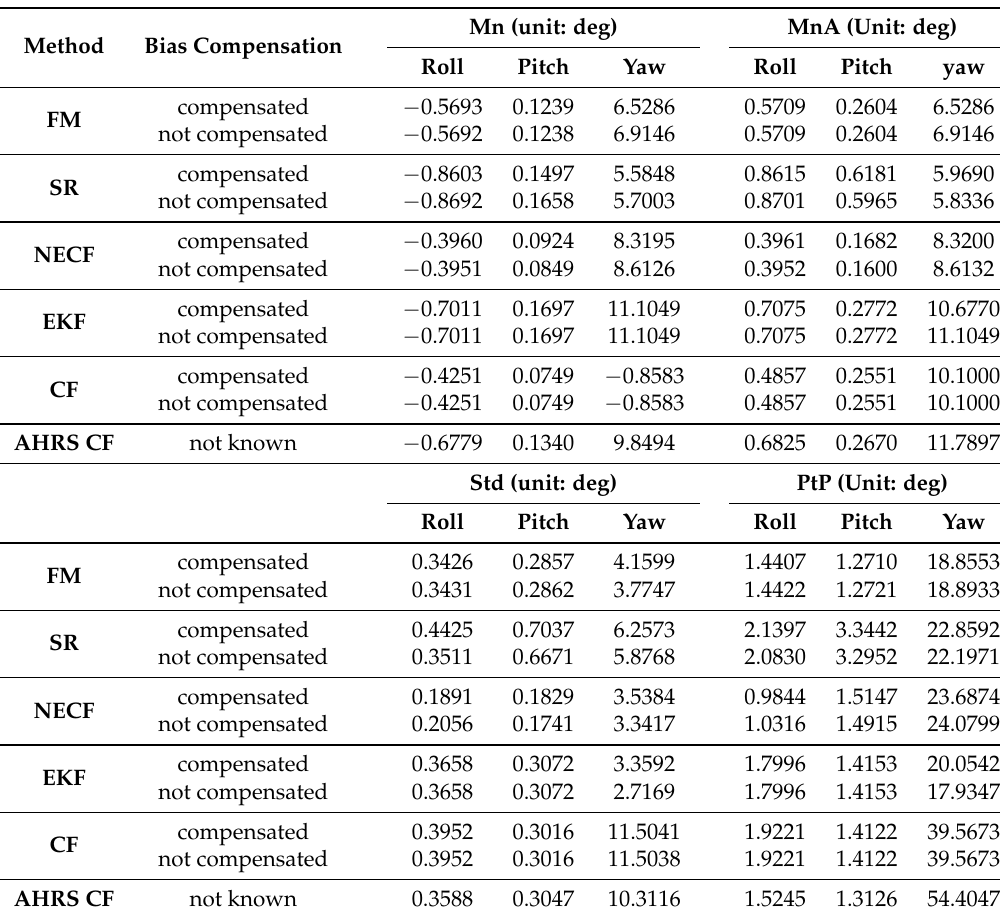
Table 3. Average of error, average of absolute error, standard deviation, and peak to peak of attitude estimation error in experiment 1 (dimension in degrees).